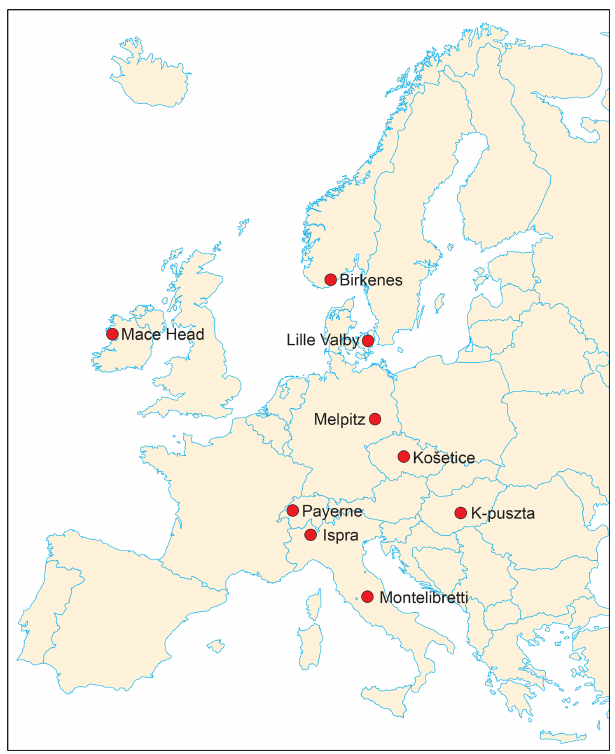
Figure 1. Overview of sampling sites participating in the carbona- ceous aerosol source apportionment study in the EMEP Intensive Measurement Periods (IMPs) in fall 2008 and winter/spring